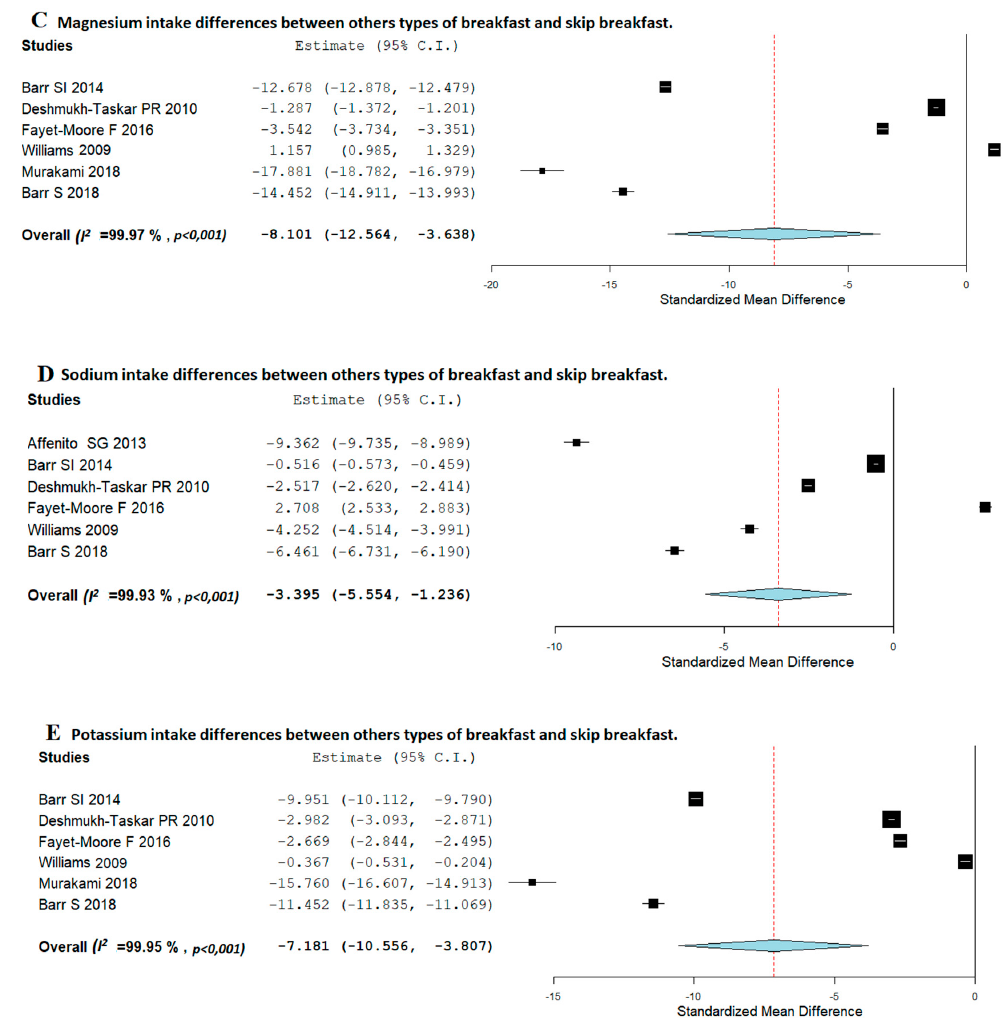
Figure 5. Random-effects meta-analysis of the effects of relationships between consumption of other types of breakfast and breakfast-skipping concerning calcium ( A ), iron ( B ), magnesium ( C ), sodium ( D ), and potassium ( E ) intake.